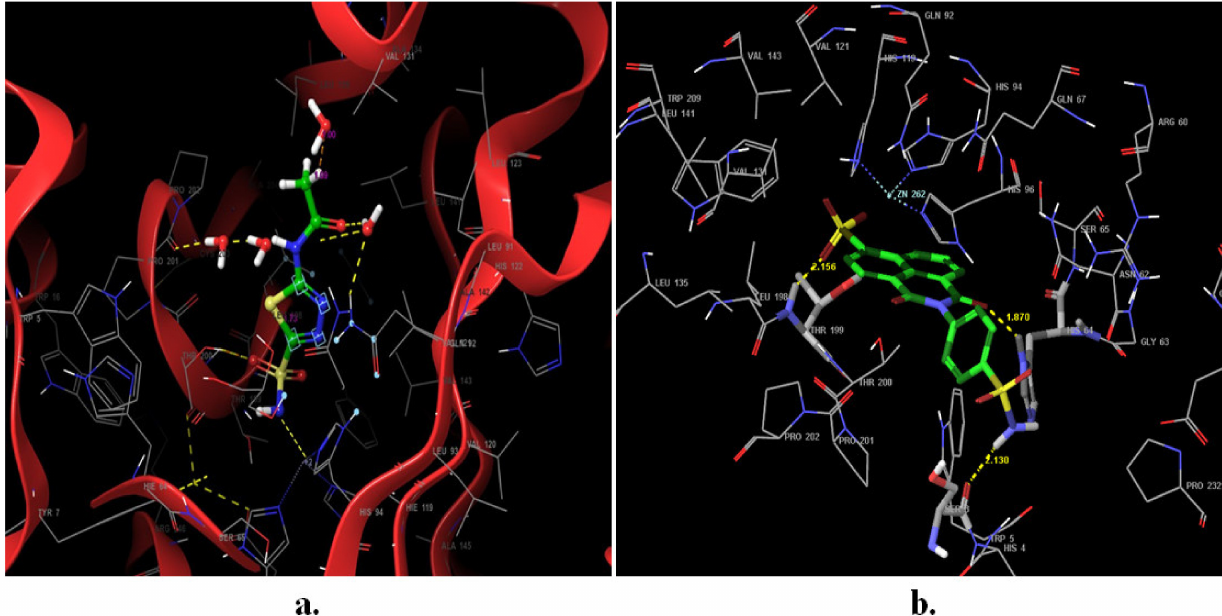
Figure 4. Protein ligand interactions in the 3IAI active site. ( a ) AAZ coordinates to the zinc ion and formed H-bond with THR 199, THR 200, and two water molecules; ( b ) Compound 1 , the deprotonate sulphonamide binds to the zinc ion and forms H-bonds with HIS 64 (1.87 Å), and THR 199 (2.156